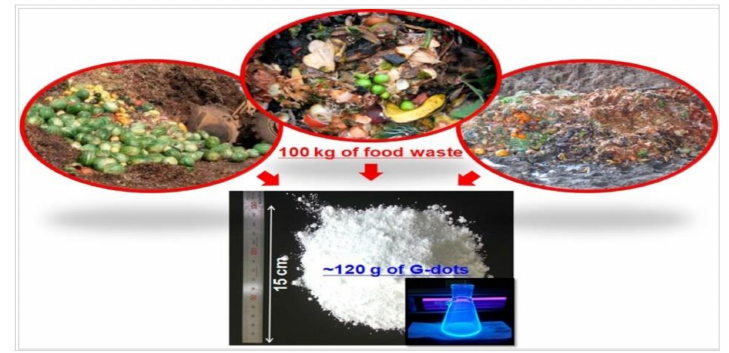
Figure 6. Large-scale synthesis of green C-dots from food wastes